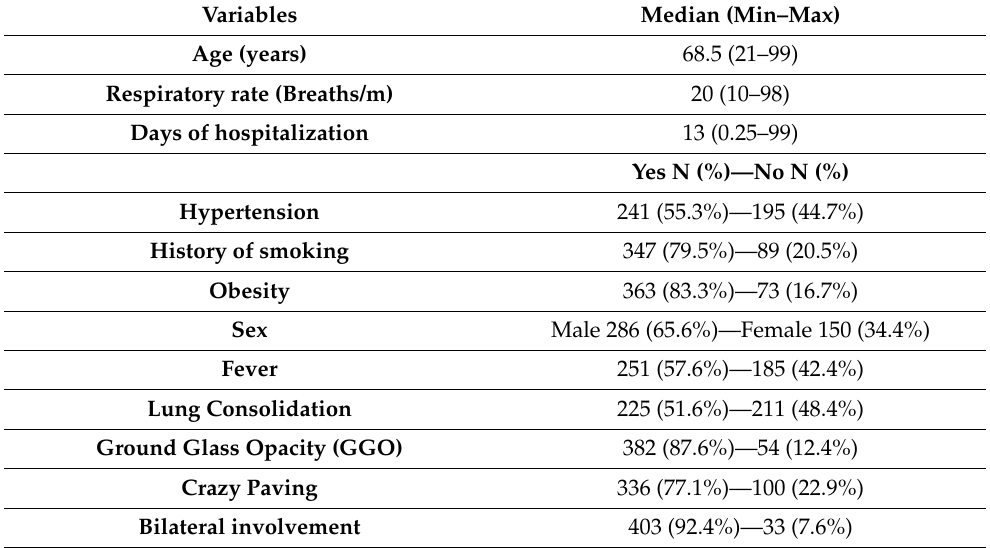
Table 1. Clinical characteristics of the patients as well as the radiological findings obtained upon radiologist inspection of the CT